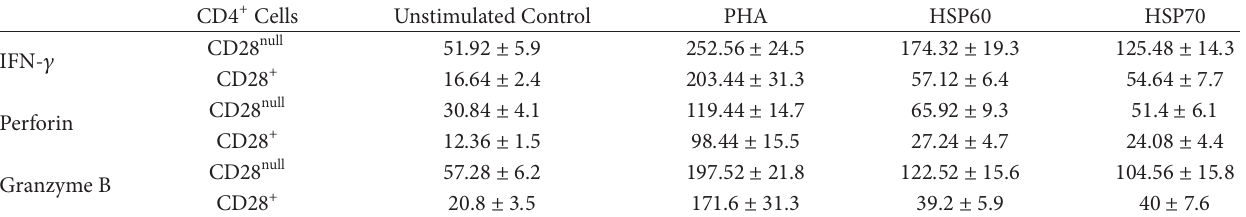
Table 2: IFN- 𝛾 , perforin and granzyme B secreted (numbers of spots) from CD4 + CD28 null cell and CD4 + CD28 + T cells during ELISPOT assay with and without stimulation with PHA (10 𝜇 g/mL), HSP60 (5ng/mL) and HSP70 (5ng/mL) in CKD subjects.